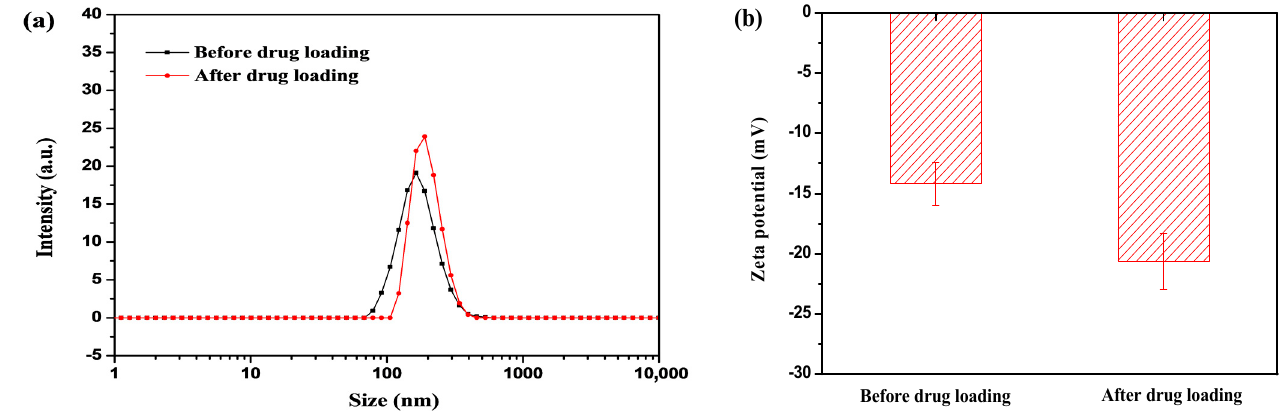
Figure 5. The size distribution ( a ) and zeta potential ( b ) of PSBMA-4 nanogels before and after drug loading.